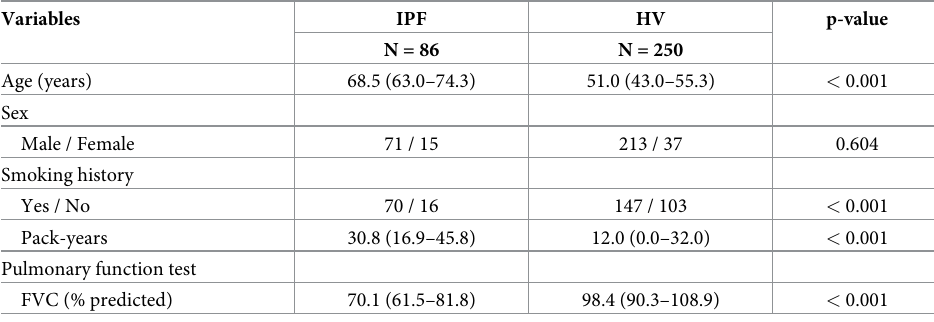
Table 1. Patient